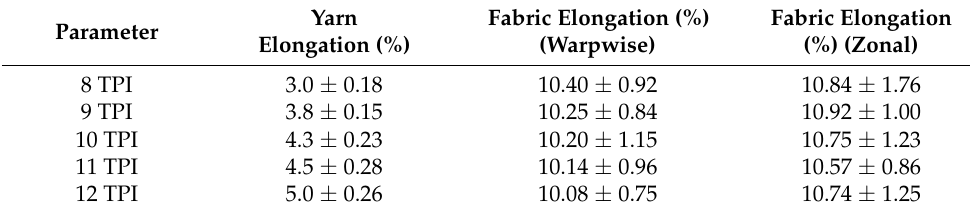
Figure 7. Tensile elongation of non-woven fabrics composed of the Ge/SS core-spun yarns. Table 3. Tensile elongation of non-woven fabrics composed of Ge/SS core-spun yarns.